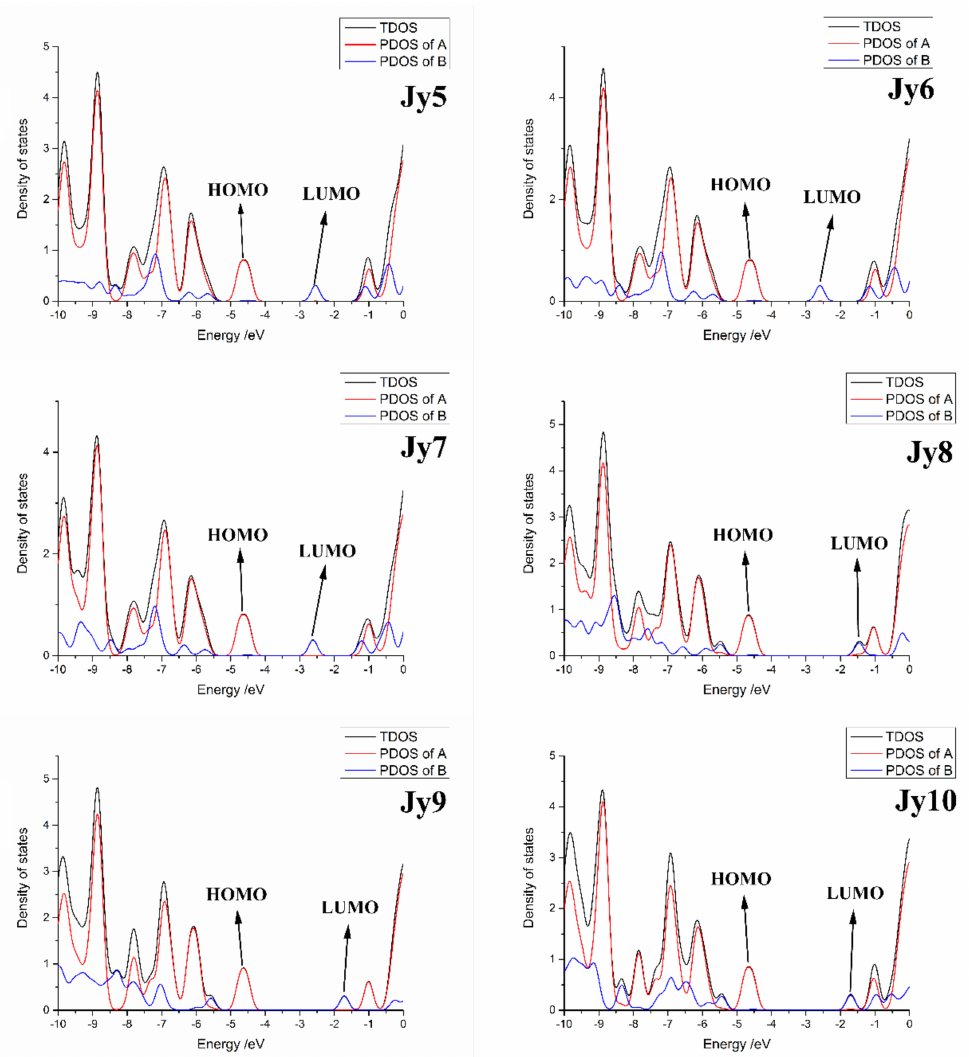
Figure 5. Density of states (DOS) of the six investigated molecules. Where the black line represents the total density of states (TDOS), the red line red line represents the partial density of states (PDOS) of defined fragment A, and the blue line represents the PDOS of defined fragment